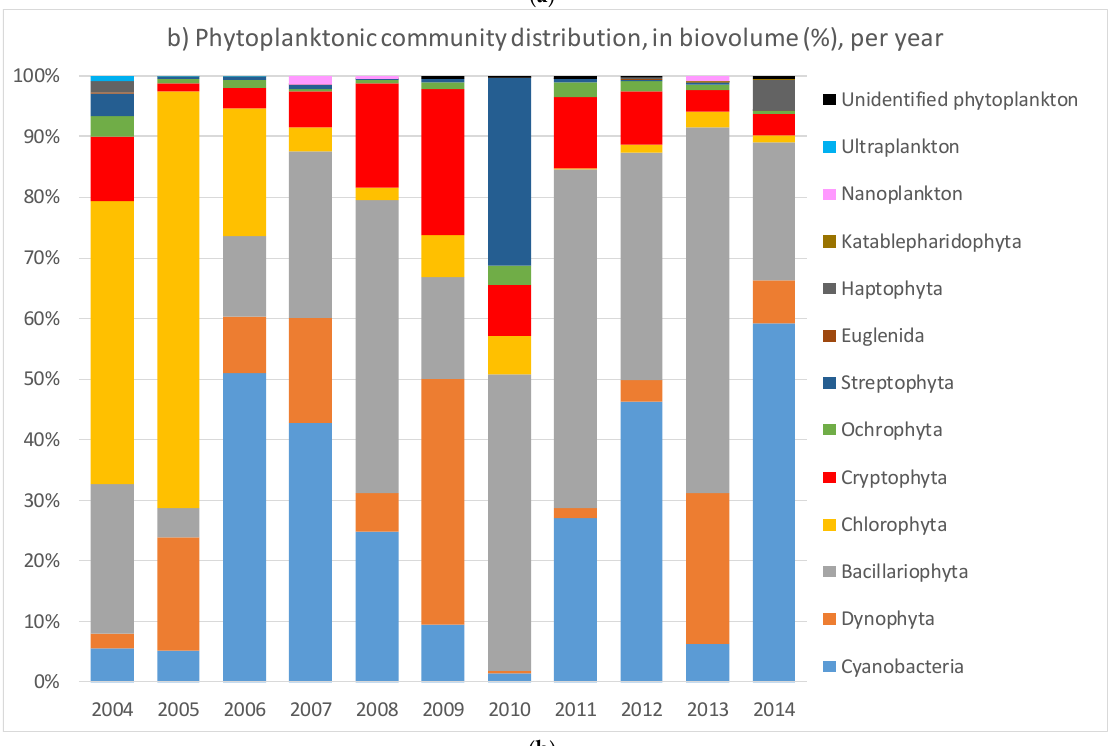
Figure 2. Distribution of the total phytoplankton community expressed in percentage (Y-axis) of the average of the annual campaign from 2004 to 2014. ( a ) On the top plot, the distribution is reported as percentage of cell density (cells/L); ( b ) on the bottom the distribution is shown as percentage of biovolume (mm 3 /m 3 ). The total cell density and biovolume values for each year are reported in Table A1 in Appendix A.